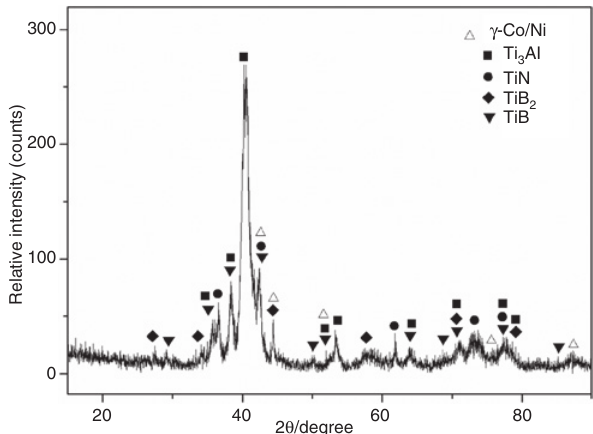
Figure 3 XRD diagram of the NiCoCrAlY-BN laser clad